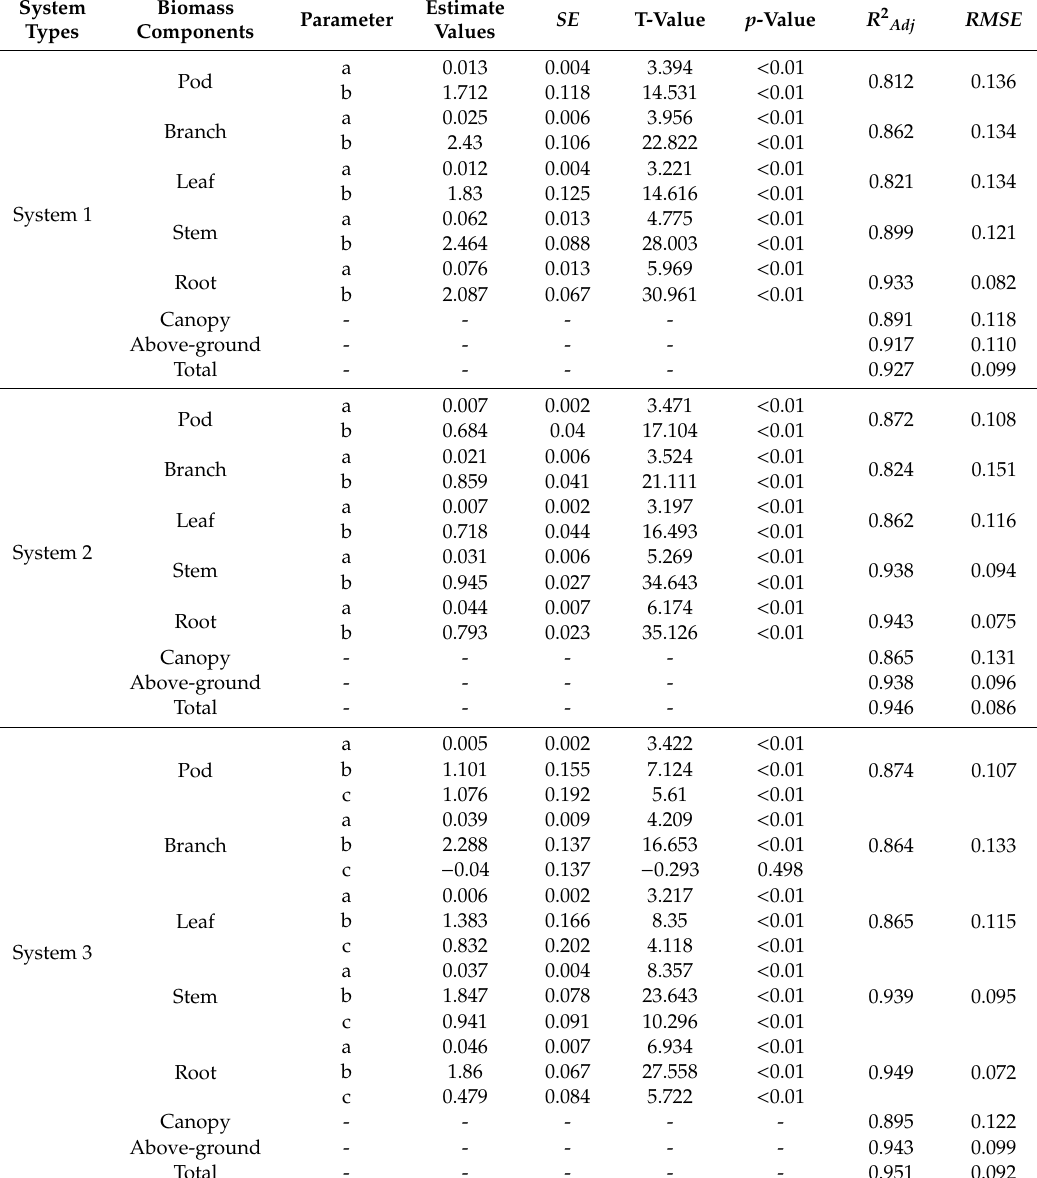
Table 3. Coe ffi cient estimates and goodness-of-fit statistics for fitting the additive system of the biomass equations using the seemingly unrelated regression (SUR) method ( N =